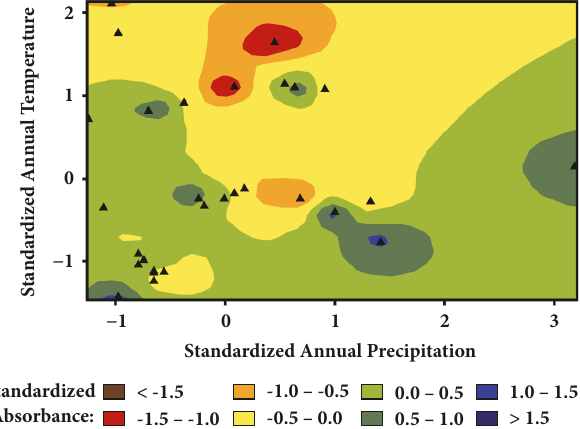
Figure 5: Interpolated map of the March ATR-FTIR standardized absorbance data, which correlates with higher unsaturation, versus the standardized temperature and precipitation.